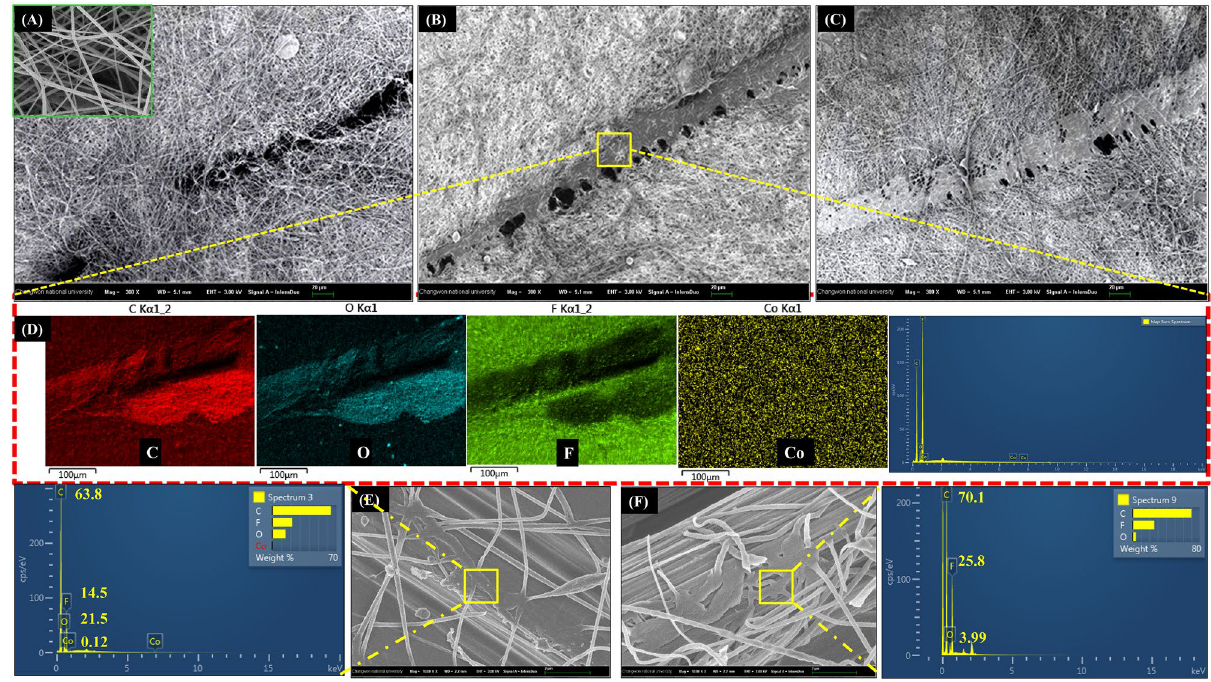
Figure 7. SEM images of VM–10TPn ( A ) scratched, ( B ) after 6 h, ( C ) after 24 h, ( D ) EDX mapping of VM-10TPn ( E ) ruptured V–10TPn nanofibers and EDX analysis at ruptured portion, and ( F ) ruptured M–10TP nanofibers and EDX analysis at ruptured